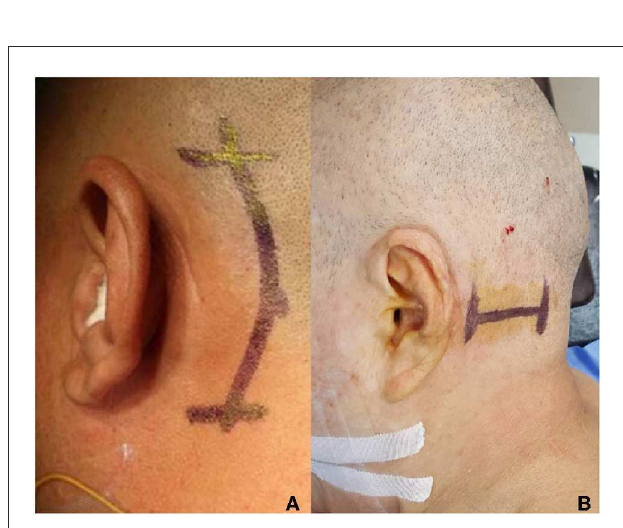
FIGURE5 Surgical incision for glossopharyngeal neuralgia, (A) longitudinal incision, and (B) transverse